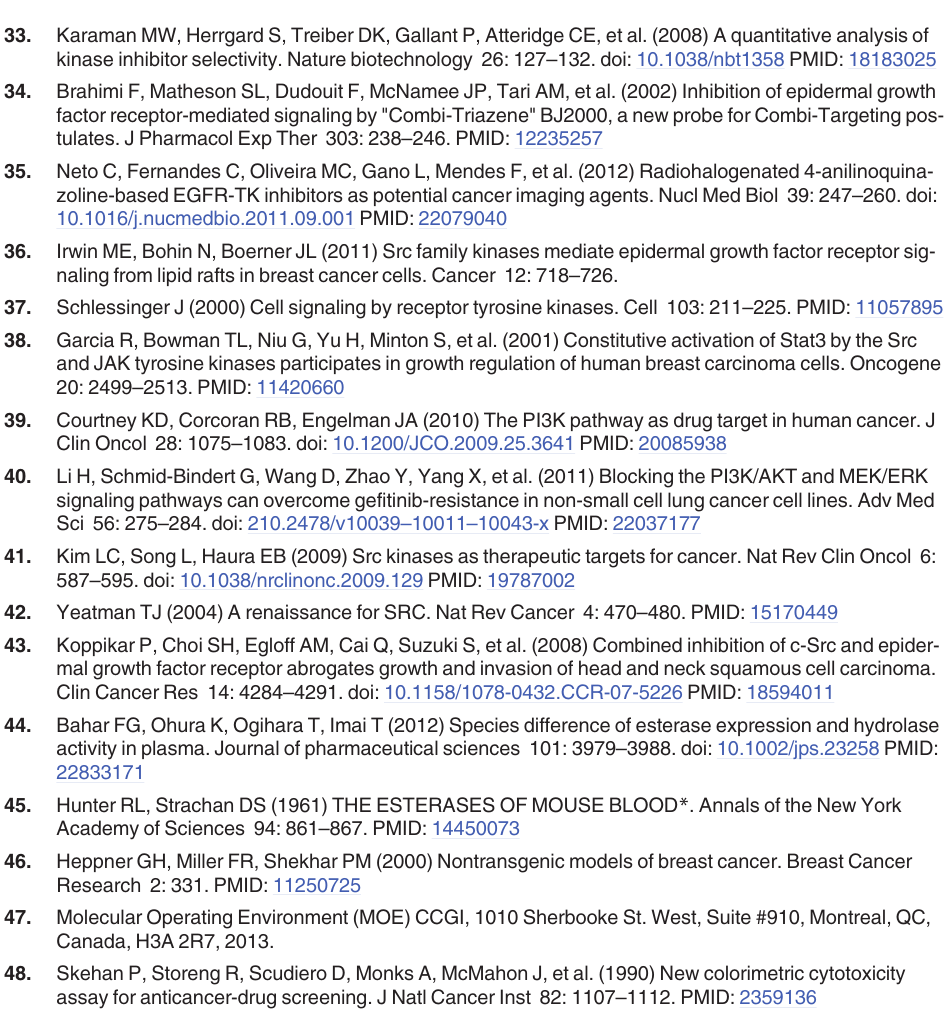
PLOS ONE | DOI:10.1371/journal.pone.0117215 February 6,